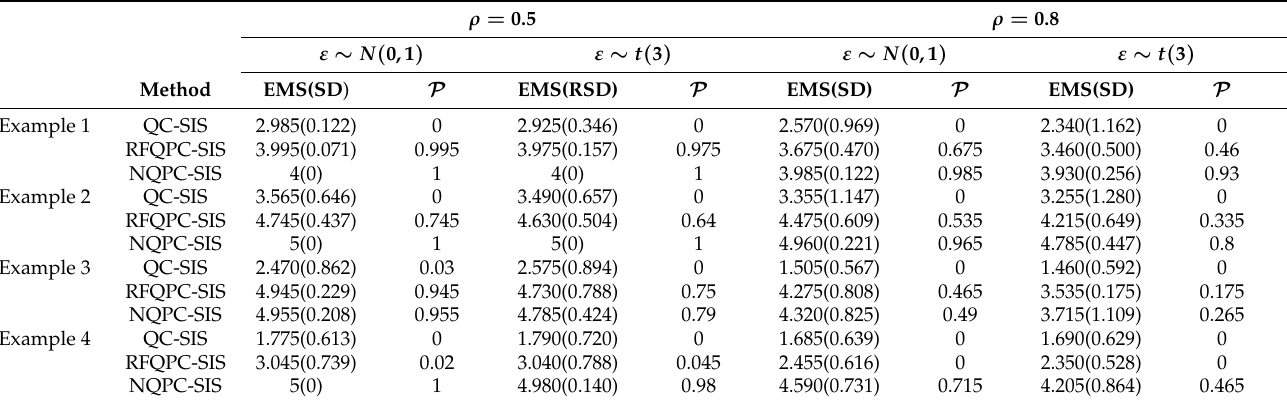
Table 6. Simulation results for Examples 1 to 4 when n = 200 and τ =